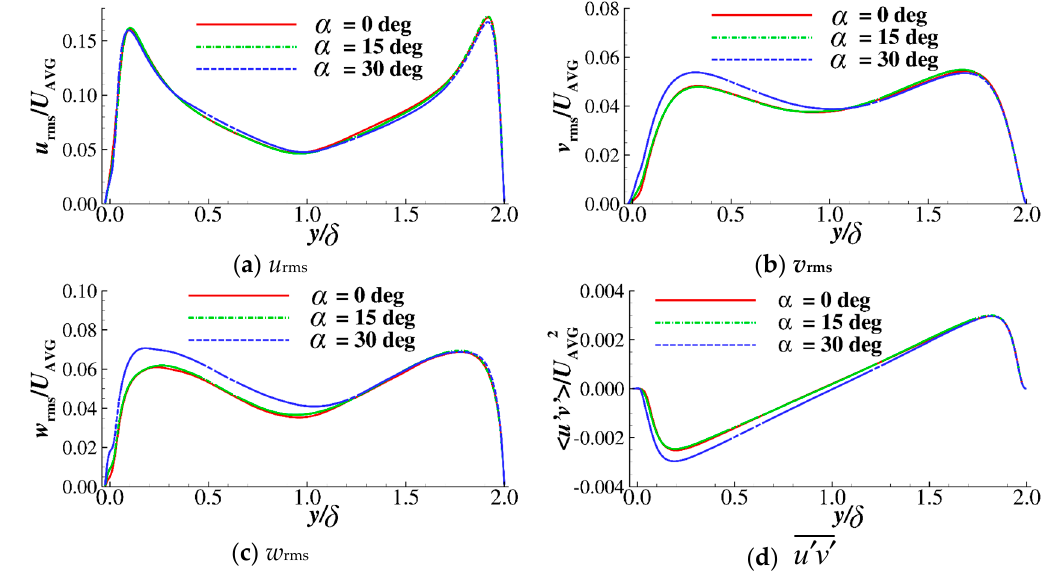
Figure 5. Root mean squares of the velocities and the Reynolds shear stresses of the channel.